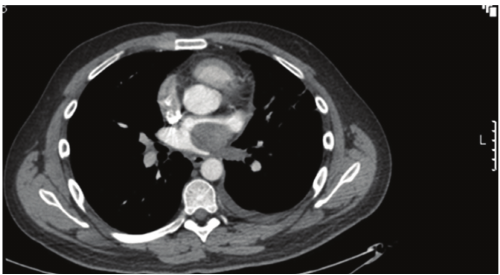
Figure 1: Computer tomogram showing left atrial mass extending into left pulmonary veins.